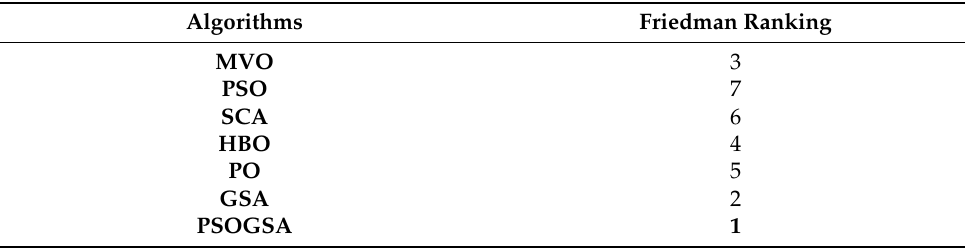
Table 19. Friedman’s ranking test for Case